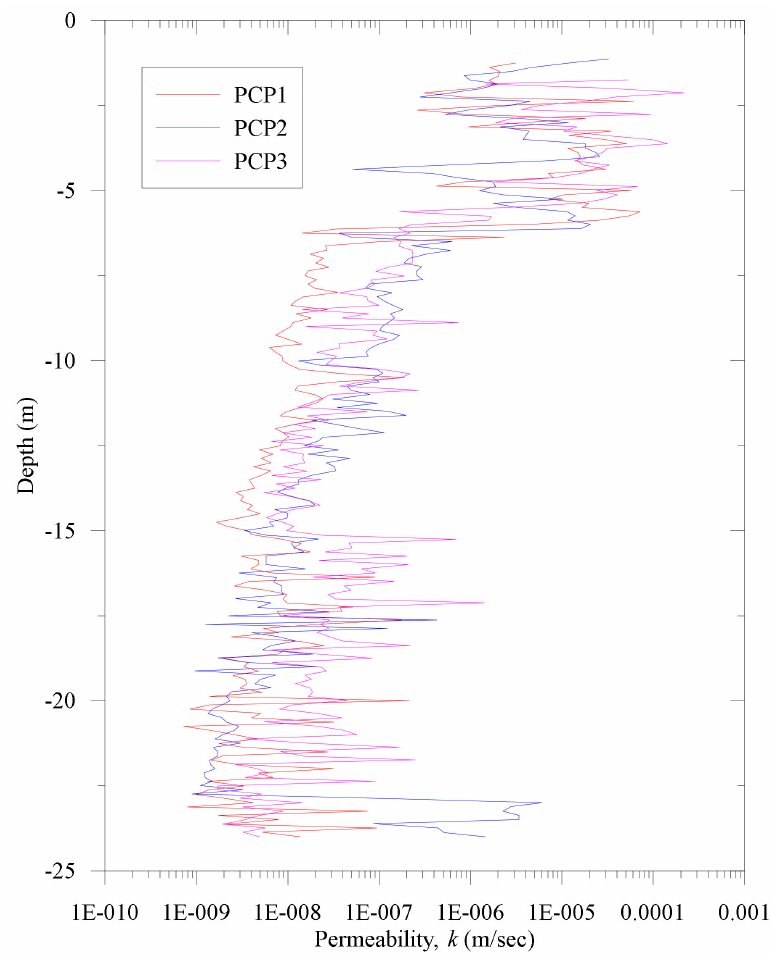
Figure 19. Permeability profile of the NBR embankment